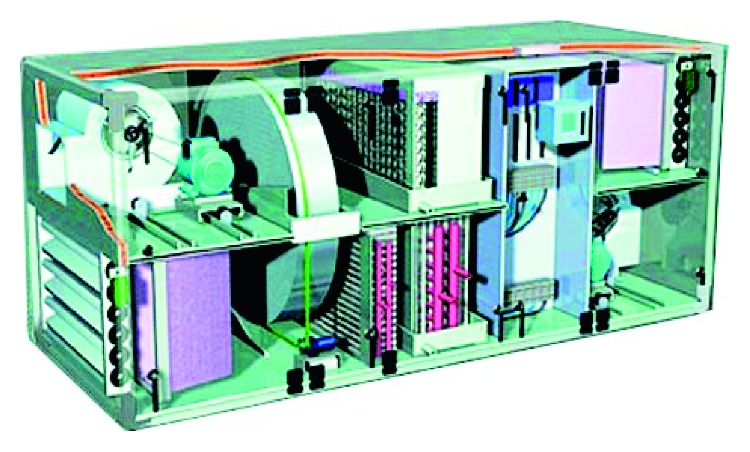
Heat exchanger wheels [19].